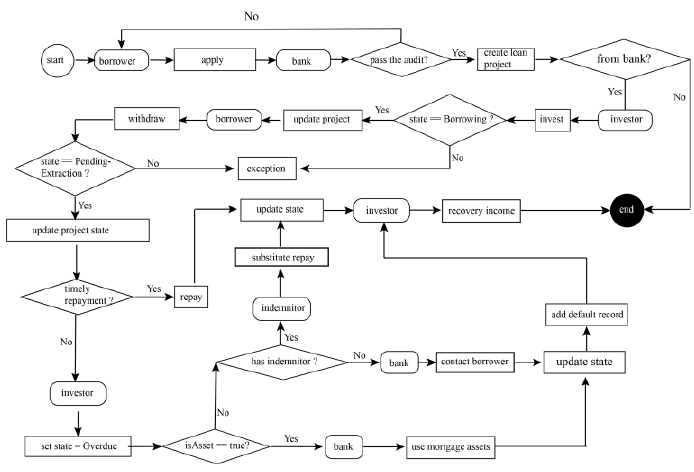
Fig. 2. Model flow